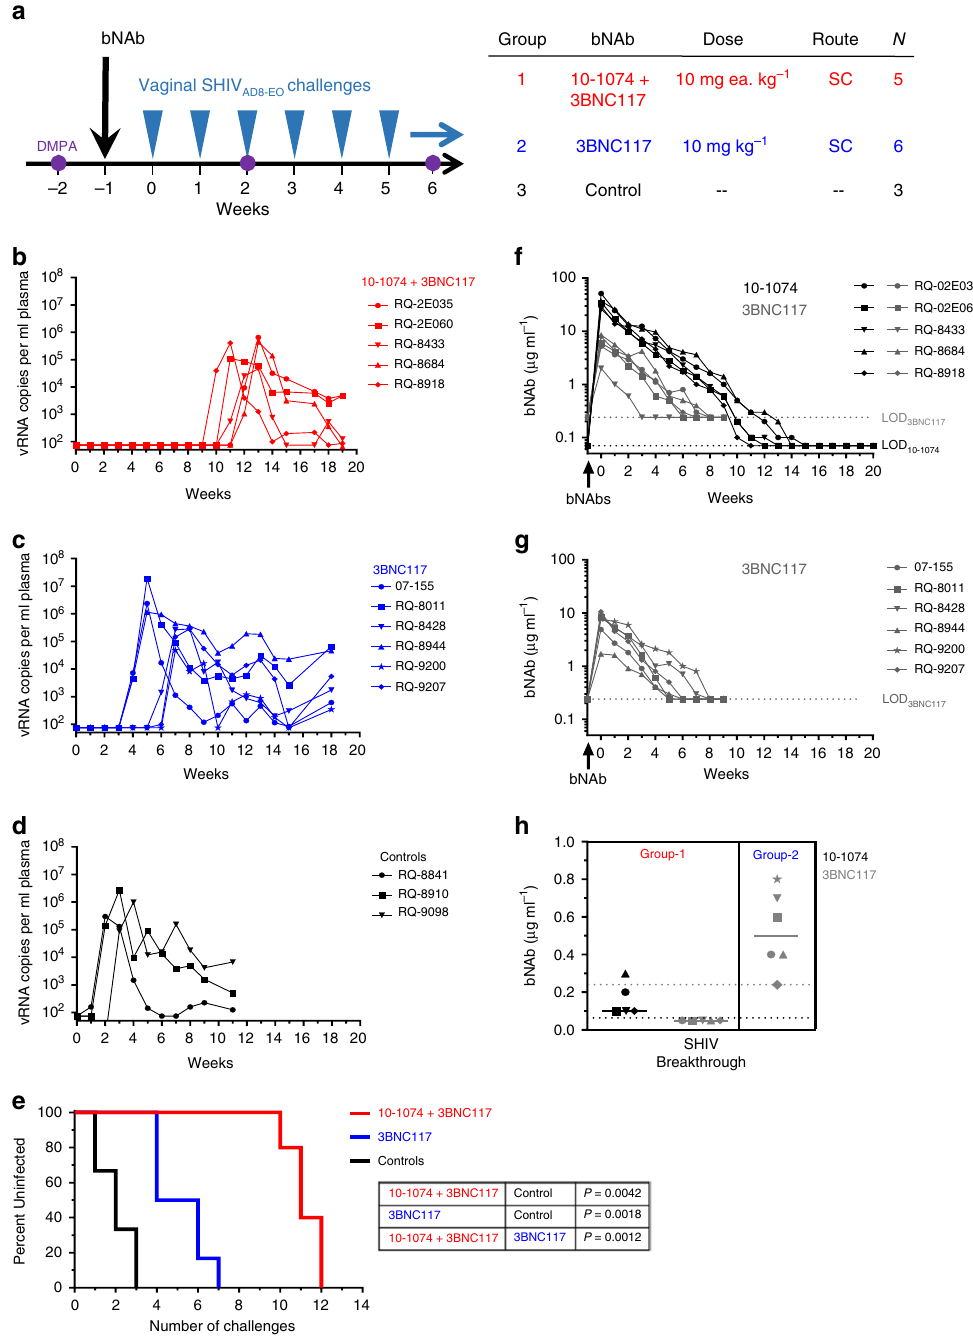
Fig. 3 Passive immunization with bNAbs 10 – 1074 and 3BNC117 in combination, or 3BNC117 singly, delays SHIV acquisition following repeated vaginal challenges in DMPA-treated macaques. a Rhesus macaques (Chinese origin) were injected subcutaneously once with a combination of bNAbs 10 – 1074 and 3BNC117 (10 mg each kg − 1 ; N = 5) or 3BNC117 singly (10 mg kg − 1 ; N = 6). Commencing 1 week later, macaques were challenged repeatedly, once per week, intravaginally with SHIV AD8-EO (300 TCID 50 ) until systemic SHIV infection was con fi rmed via plasma viral load assay. Control macaques ( N = 3) received no antibody but were challenged identically. Animals in both groups received DMPA (30 mg) intramuscularly at 2 weeks before the fi rst SHIV challenge and every 4 weeks thereafter to normalize SHIV susceptibility. Plasma viral loads (vRNA copies ml − 1 ) for macaques in the combination bNAb group ( b ), single bNAb group ( c ) or untreated control group ( d ). Symbols denote individual animals. e Percentages of macaques remaining uninfected at 7 days following administration of the indicated cumulative number of SHIV challenges. Statistical differences between groups were analyzed using a two- sided log-rank test. Plasma levels of 10 – 1074 ( μ g ml − 1 ) or 3BNC117 ( μ g ml − 1 ) were determined via TZM-bl neutralization assays using 10 – 1074-sensitive pseudovirus X2088.c9 or 3BNC117-sensitive pseudovirus Q769.d22 for macaques that received both 10 – 1074 and 3BNC117 ( f ) or 3BNC117 alone ( g ). h Plasma concentrations of 10 – 1074 or 3BNC117 in individual macaques ( N = 5 in Group-1, N = 6 in Group-2) at the time of SHIV breakthrough (values from f (Group-1) or g (Group-2)). Solid lines denote group medians; dotted lines indicate the limits of detection for 10 – 1074 (black) or 3BNC117 (gray). Source data are provided in Supplementary Tables or a Source data fi